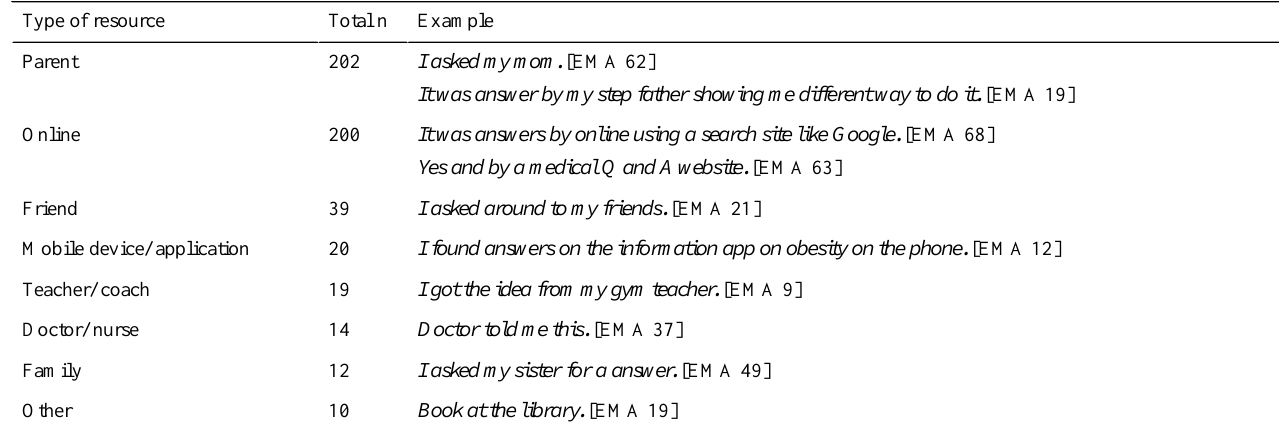
Table 3. Types of information sources and